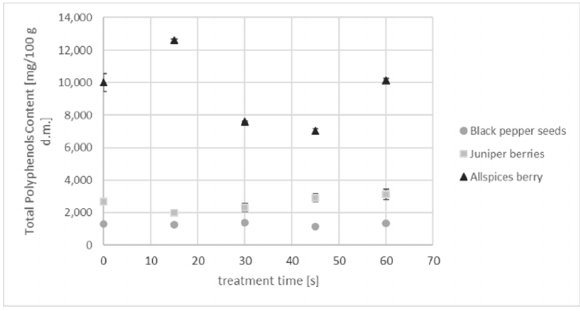
Figure 7. Total polyphenolic content of plasma treated spices.